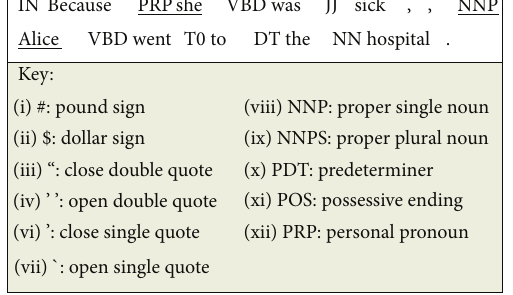
Figure 1: Output of speech